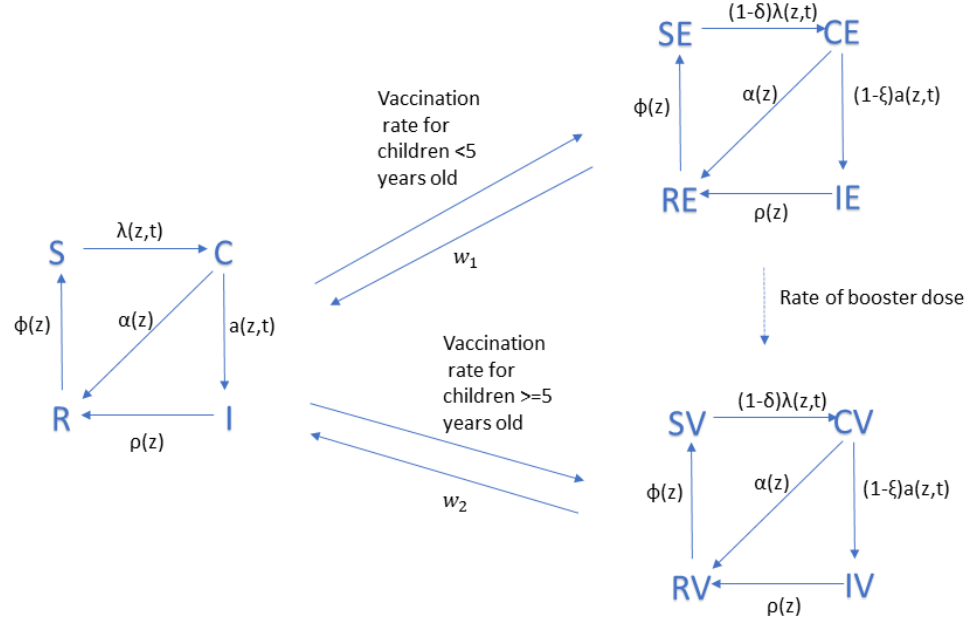
Figure A1. Flow diagram of the model with vaccination. Susceptible individuals become carriers with age and time dependent force of infection ( λ (z,t)), which is reduced by the vaccine efficacy against carriage ( δ ) for vaccinated people. Similarly, the age and time dependent rate at which carriers develop disease (a(z,t)) is reduced by the vaccine efficacy against disease ( ξ ). Carriers and diseased individuals recover at a rate α and ρ , respectively. Temporary immunity wanes at a rate ϕ , while vaccine induced protection wanes at a rate w 1 for children vaccinated before the age of 5 years and w 2 for people vaccinated after their 5th birthday. People die at an age-specific natural mortality rate not shown here.